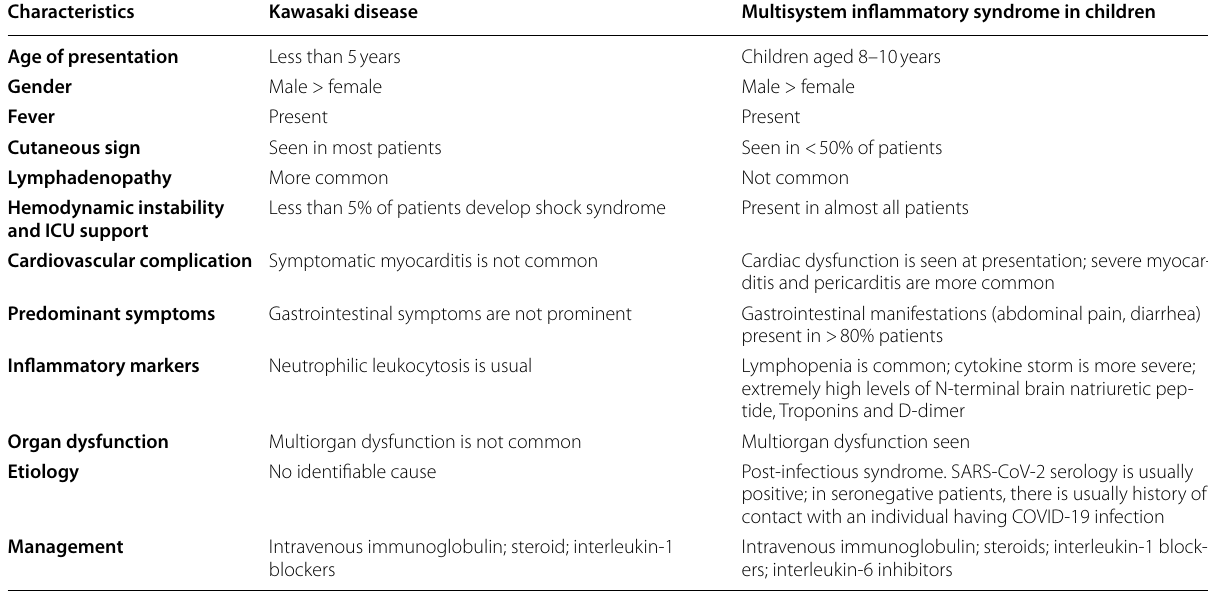
SARS-CoV- 2 severe acute respiratory syndrome coronavirus type 2, COVID-19 coronavirus disease